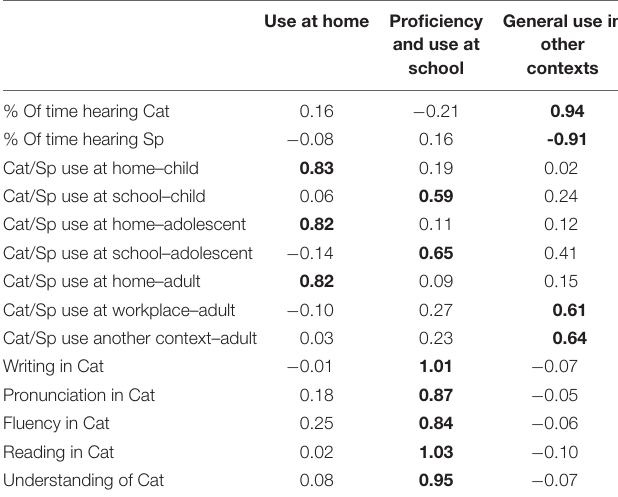
TABLE 2 | Standardized loadings of each item and factor, as a result of our exploratory factor analysis (EFA), with the strongest loading for each item indicated in